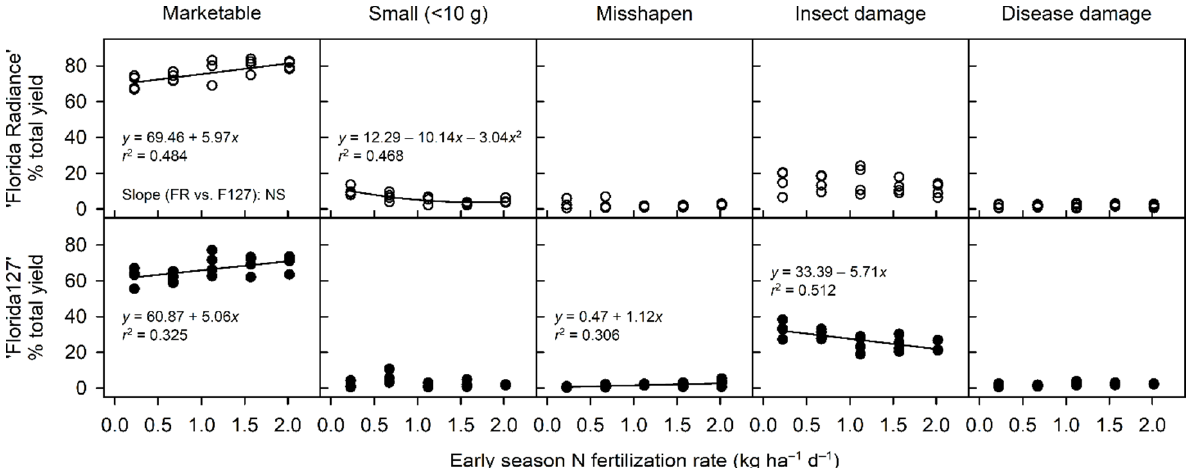
Figure 4. Marketable and unmarketable yield responses of two strawberry cultivars to different early-season nitrogen (N) fertilization rates in the 2014–2015 growing season. Treatments are as described in Table 2. Five models were fit to each data set: linear, quadratic, exponential plateau, exponential decay, and sigmoidal models. Only the significant ( p ≤ 0.05) and best-fit model is shown for each data set. No regression line is shown when none of the models had a significant fit. FR = Florida Radiance. F127 = Florida127. NS = non-significant.